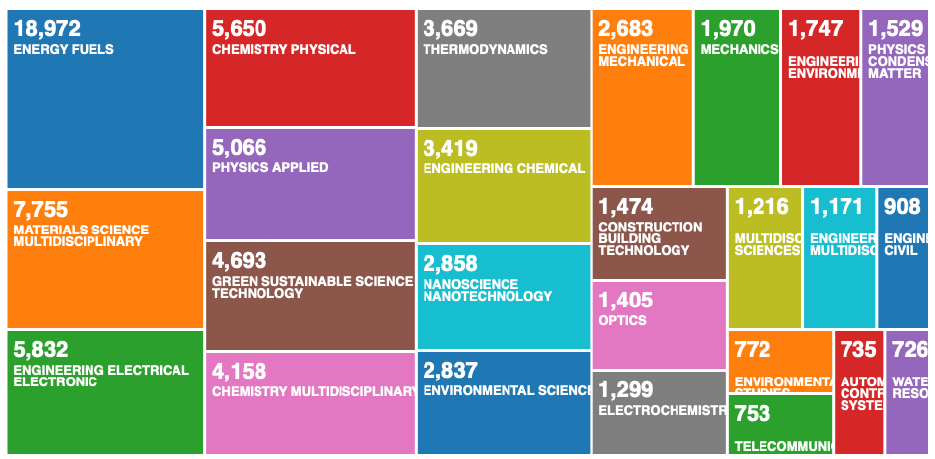
Figure 6. Publications according to WOS research categories for solar energy research (between 1900 and 2020).